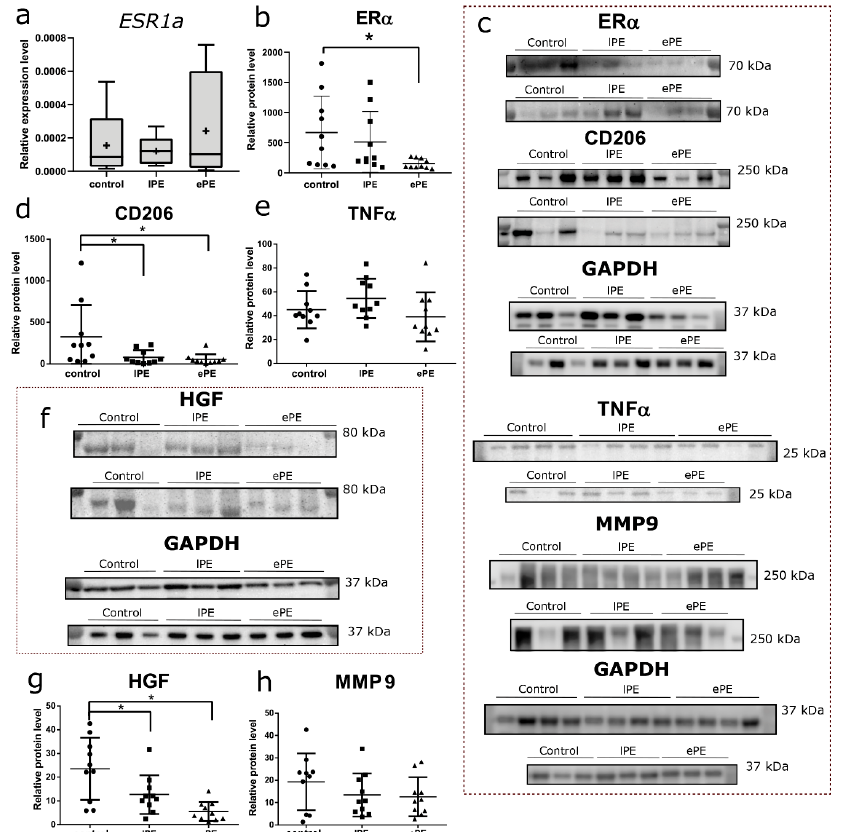
Figure 2. PCR and Western blot analysis of gene and protein expression by decidual macrophages for the control, late-onset preeclampsia (lPE) and early-onset preeclampsia (ePE) groups. Relative expression levels of ESR1a gene in the isolated decidual macrophages ( a ). Relative protein levels of ER α ( b ), CD206 ( d ), TNF α ( e ), HGF ( g ) and MMP9 ( h ) in decidua basalis, normalized by GAPDH level. Representative Western blotting membranes stained with antibodies to ER α , CD206, TNF α , GAPDH and MMP9 ( c ), HGF and GAPDH ( f ). * p < 0.05 compared to the control group according to ANOVA with Dunnett’s post hoc test.